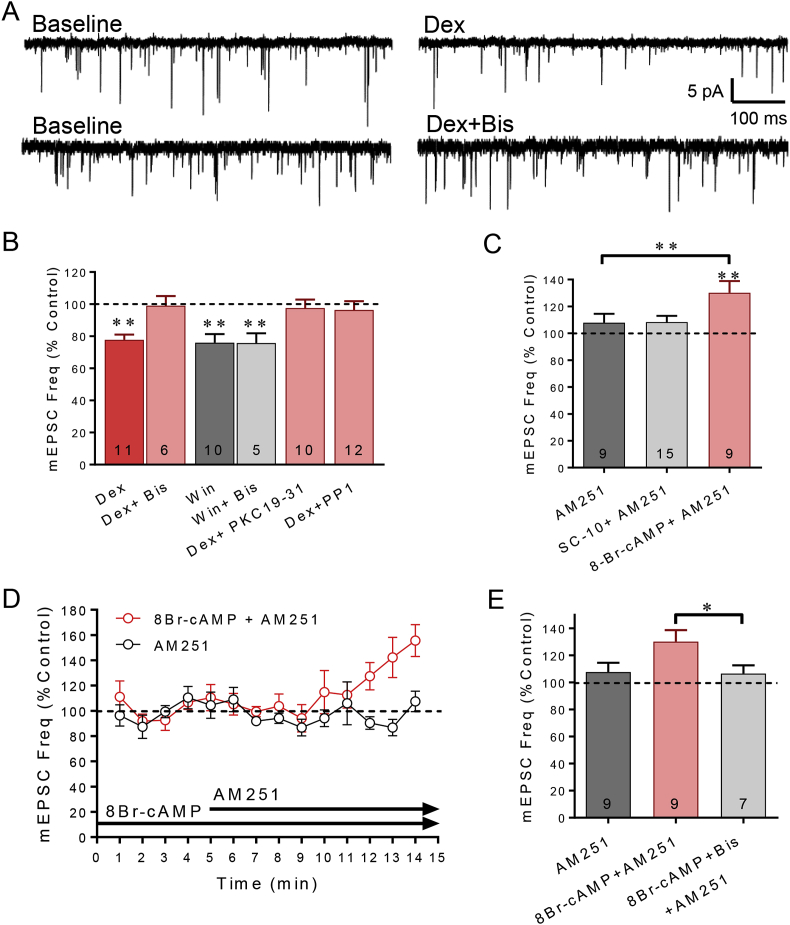
PKC, PKA, and Src signaling in the rapid glucocorticoid-induced suppression of excitation. A. Representative traces of the effect of dexamethasone on mEPSC frequency compared to baseline in the absence (Dex) and presence of the broad-spectrum, membrane-permeant PKC inhibitor bisindolylmaleimide (Dex + Bis). B. Bath application of Bis (Dex + Bis) (n = 6) blocked the Dex-induced decrease in mEPSC frequency but did not block the decrease in mEPSC frequency elicited by bath application of the CB1 receptor agonist Win55,212 (baseline vs. Win + Bis, p < 0.01; Win vs. Win + Bis, p = 0.68). The Dex-dependent decrease in mEPSC frequency was also prevented by intracellular application of the peptide PKC inhibitor (Dex + PKC19-31 vs. Dex) (p < 0.01). Bath application of the Src inhibitor PP1 blocked the Dex-induced suppression of mEPSC frequency (Dex + PP1). C. The CB1 receptor antagonist AM251 had no effect on mEPSC frequency alone, indicating that there was not a baseline tonic release of endocannabinoid at glutamate synapses. Following intracellular application of the PKC activator SC-10 (50 μM) via the patch electrode, AM251 had no effect on mEPSC frequency, suggesting that PKC activation did not cause endocannabinoid release. Following intracellular application of the PKA activator 8-Br-cAMP (100 μM) via the patch electrode, AM251 caused a significant increase in mEPSC frequency, suggesting that PKA activation caused an endocannabinoid-dependent suppression of mEPSCs. D. Running average of mEPSC frequency with continuous intracellular application of the PKA activator 8-Br-cAMPs via the patch pipette (100 μM) and following bath application of the CB1 receptor antagonist AM251 (cAMP + AM251, 4 μM). AM251 caused an increase in mEPSC frequency in recordings in which 8-Br-cAMP was included in the patch electrode. E. Summary bar graph of the mean effects of PKA activation and CB1 receptor and PKC inhibition on normalized mEPSC frequency. Blocking CB1 receptors alone had no effect on mEPSC frequency (AM251) but caused an increase in mEPSC frequency following intracellular activation of PKA (cAMP + AM251), suggesting that postsynaptic PKA activation caused endocannabinoid release. Blocking PKC activity with bath application of bisindolylmaleimide blocked the AM251-induced increase in mEPSC frequency in neurons recorded with 8BR-cAMP in the electrode (cAMP + Bis + AM251), suggesting that the postsynaptic PKA activation of endocannabinoid release was PKC-dependent. *, p < 0.05; **, p < 0.01.